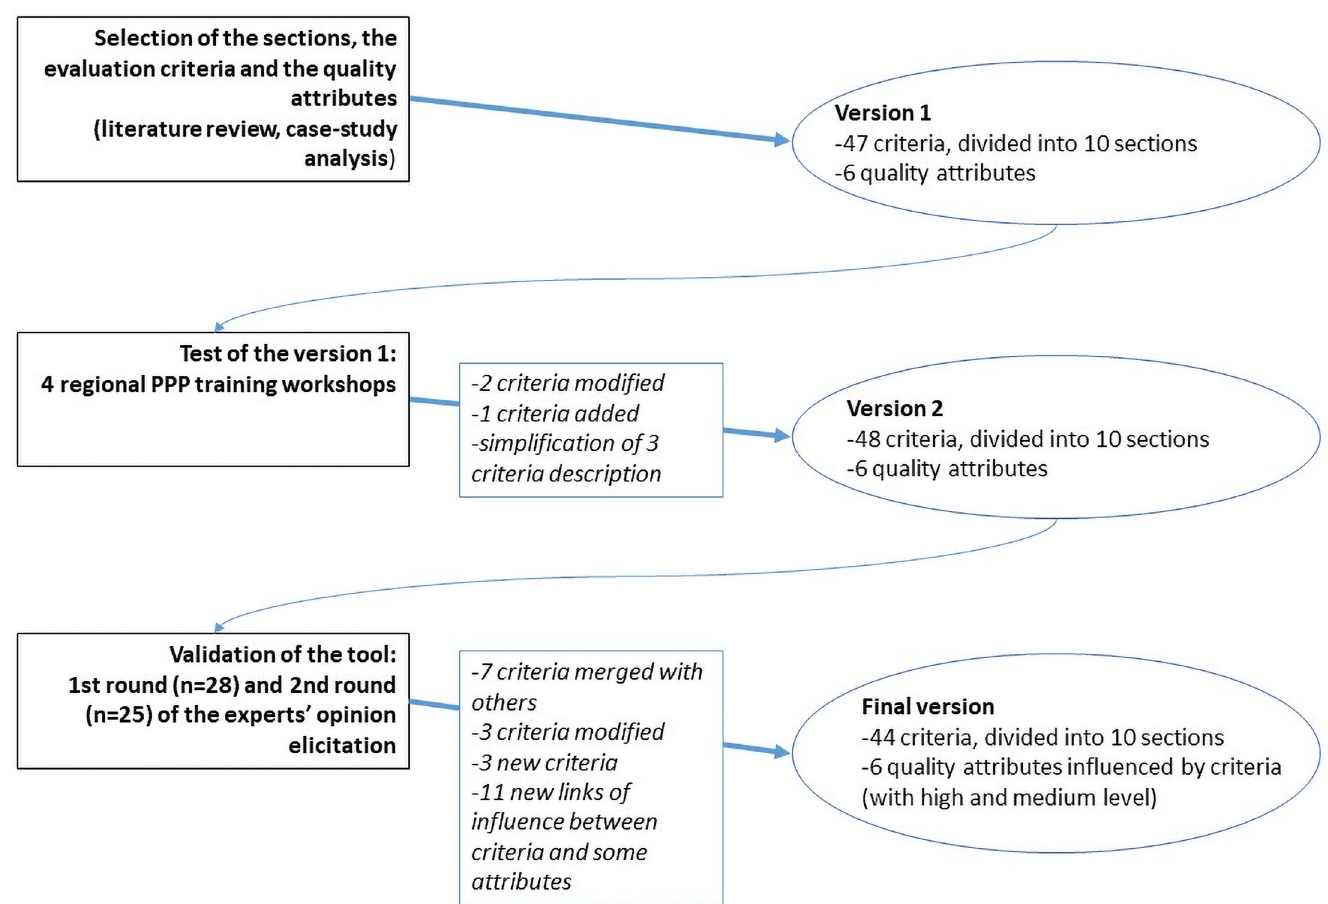
Fig 1. The process of the tool development. The different steps of this study captured the viewpoints of public and private partners, catalyzers and actors impacted by the public-private partnerships. PPP: public-private partnership.